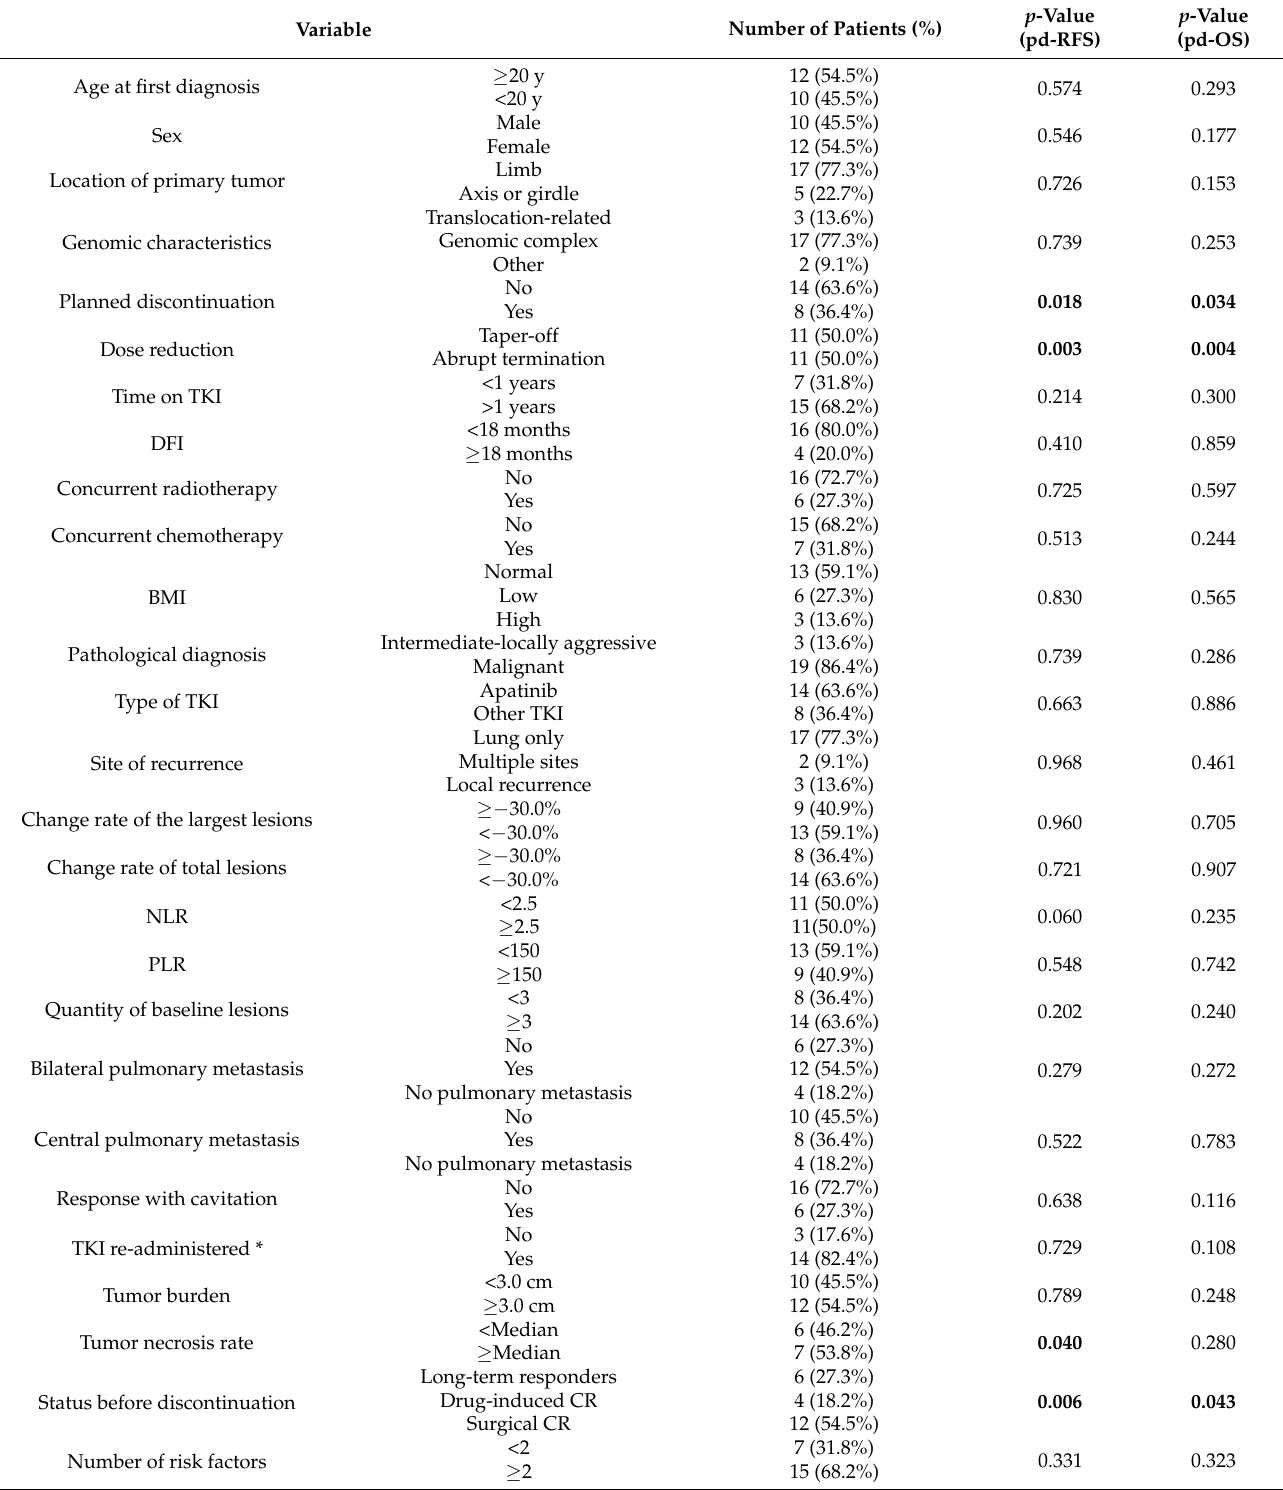
Table 3. Kaplan–Meier Analysis of the independent prognostic factors for pd-RFS and pd-OS among the